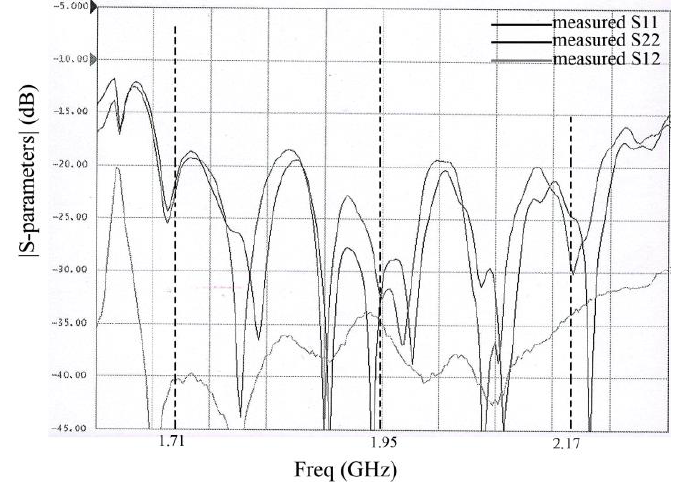
Fig.4. The measured return loss and isolation of the manufactured antenna